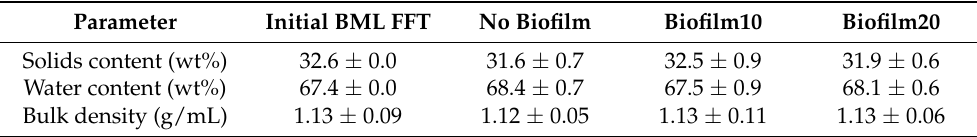
Table 3. FFT characterization data for the initial BML FFT and FFT in No Biofilm, Biofilm10, and Biofilm20 jars prior to mixing tests. Results are presented as average ± one standard deviation of replicates. Biofilm10 corresponds to 10-week-old biofilms; Biofilm20 corresponds to 20-week- old